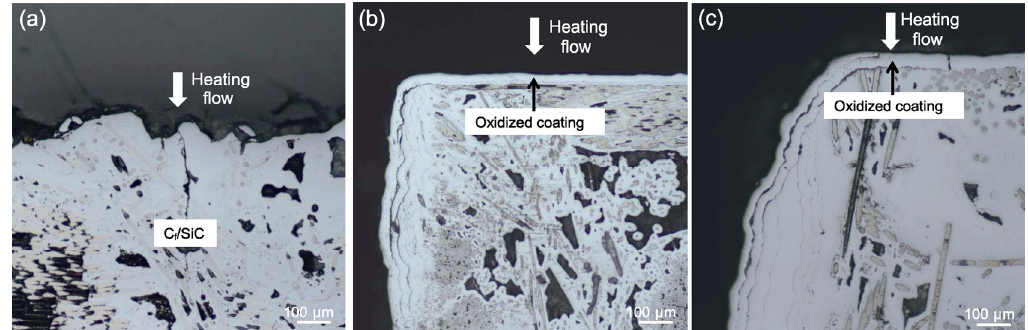
Fig. 8 Optical images of the SiC coatings on C f /SiC after oxidation at (a) active domain (~1370 ℃ , ~1 kPa), (b) passive